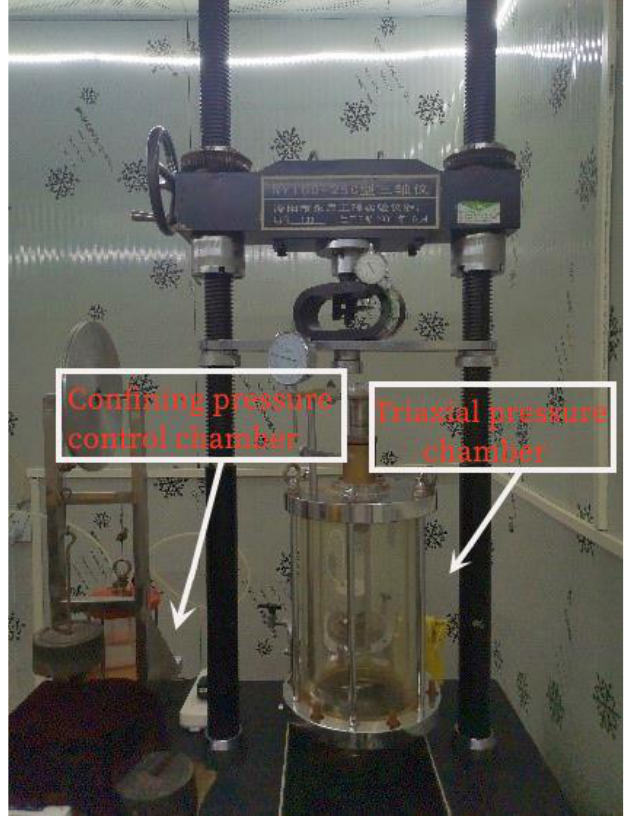
Figure 1. SY100-25 °C temperature-controlled triaxial test instrument . Figure 1. SY100-25 ◦ C temperature-controlled triaxial test